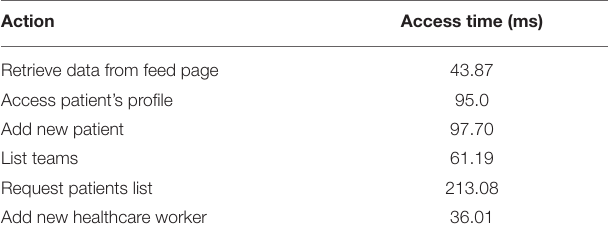
TABLE 3 | Access times to different test requests performed to the API of the real-time monitoring